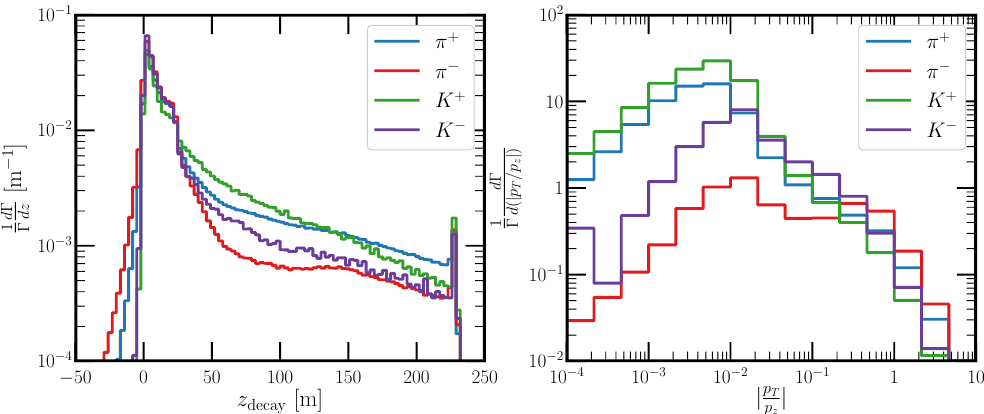
Figure 2 . Decay distributions of long-lived charged mesons as determined by the DUNE collabo- ration [46] using Geant4 and Fluka simulations of charged meson transport through the DUNE focusing horns. The left panel presents decay distributions in terms of z decay , the longitudinal po- sition of the decay. The right panel presents decay distributions in terms of the ratio of transverse and longitudinal momentum, p T =p z , as a proxy for how well-focused the corresponding mesons j j are. In both panels, we show (cid:25) + distributions (blue), (cid:25) (cid:0) distributions (red), K + distributions (green), and K (cid:0) distributions (purple). This (cid:12)gure is for operation in neutrino mode, in which positively charged mesons are